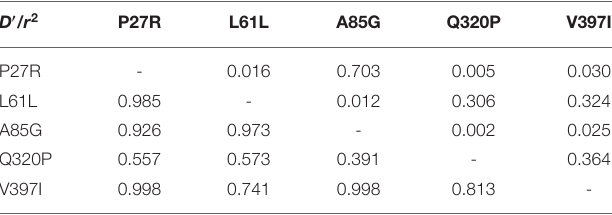
TABLE 4 | Linkage disequilibrium parameters ( D ′ and r 2 ) among P27R, L61L, A85G, Q320P, and V397I loci of the GDF9 gene in Shaanbei white cashmere (SBWC) goats.